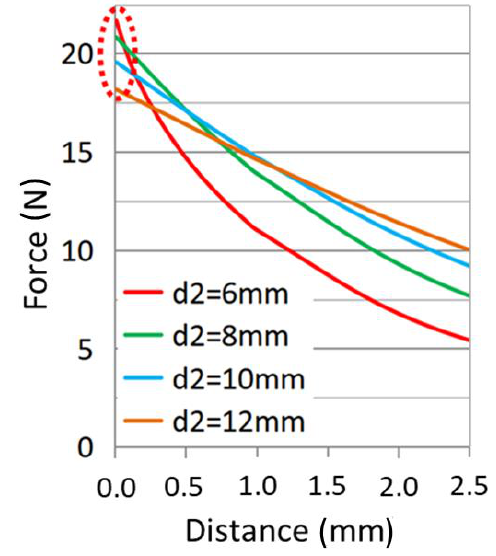
Figure 3. Attraction forces between two permanent magnets having height 10 mm and diameters d1 = 6 mm and d2 = 6–12 mm versus distance between them.